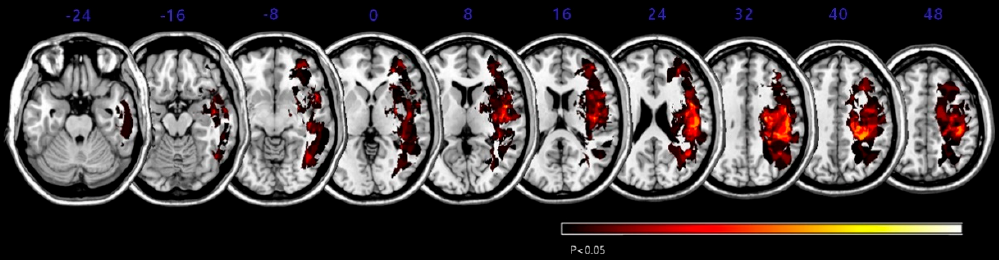
Figure 2. Voxel ‐ based lesion symptom mapping (VLSM) was combined with statistical non ‐ parametric mapping (SnPM) to associations of lesion areas with Scale for Contraversive Pushing (SCP) scores. Lesion overlay map in Montreal Neurologic Institute (MNI) space for SCP scores. Only voxels significant at p < 0.05 (familywise error correction) are shown in red to yellow color. Numbers are the z ‐ coordinates in MNI space; the patient’s right hemisphere is on the right side of the figure. After adjusting for lesion volume as a nuisance covariate, no lesion areas were definitively associated with SCP. Table 3. MNI coordinates of brain lesions associated with lateropulsion.